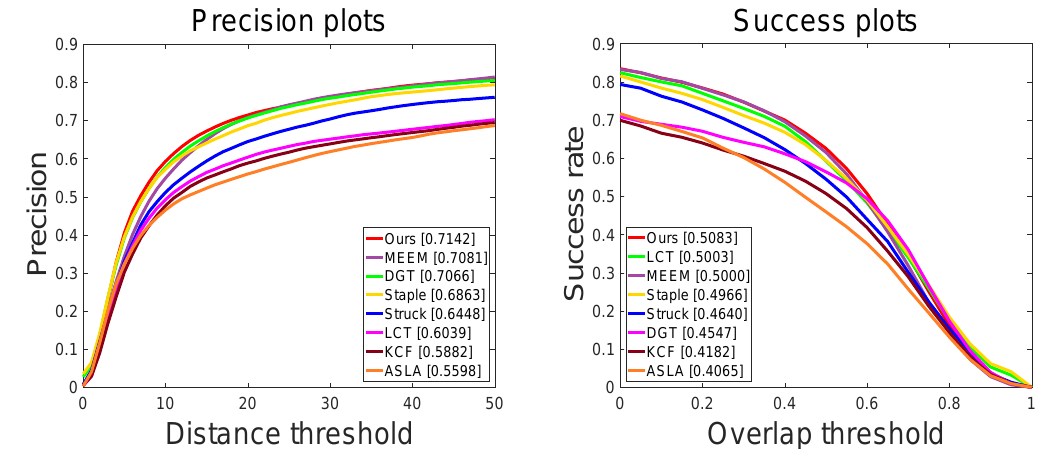
Figure 7. The evaluation results on TColor-128 (Temple Color). The left shows the precision plots, and the right is the success